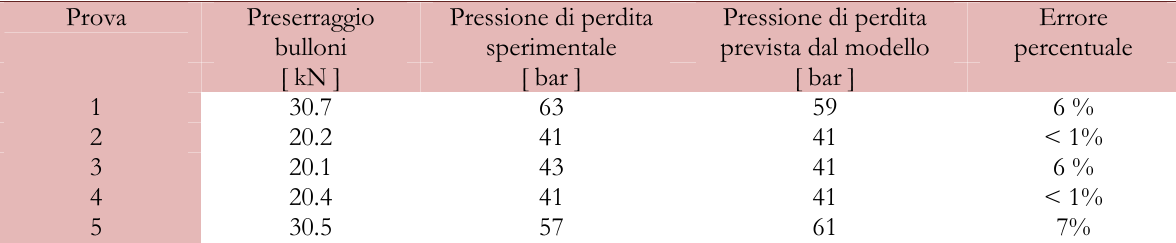
Tabella 1: Risultati delle prove in scala